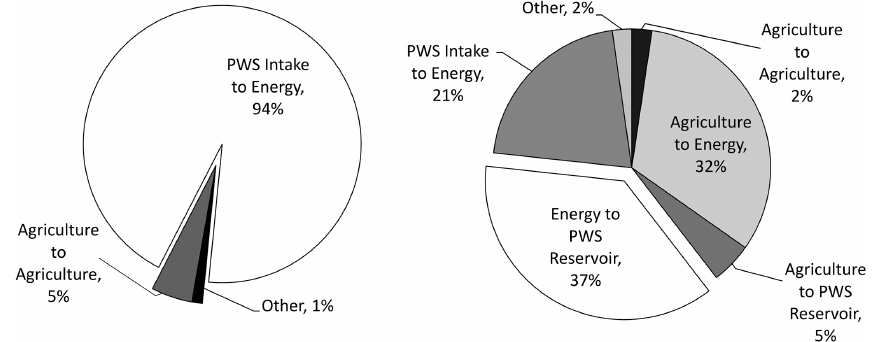
Figure 7. Proportion of the total annual volume of trade transactions between sectors under the current (left panel) and proposed (right panel) licensing systems as simulated in a dry year.